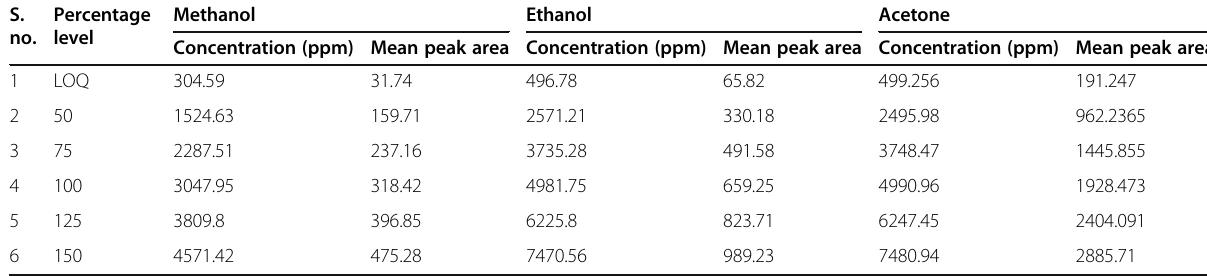
Table 5 Linearity and range of solvents S. Percentage no. level